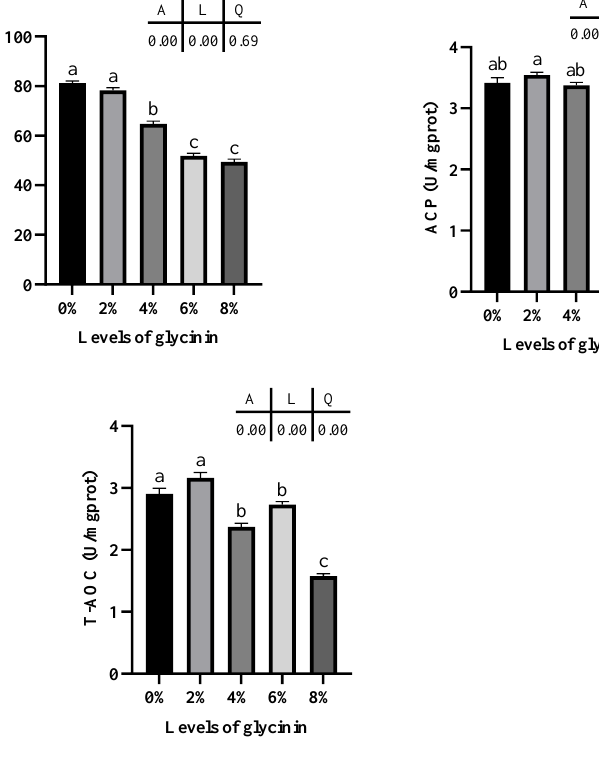
Figure 5. Protein metabolism enzyme activities in liver of hybrid yellow catfish fed with different glycinin levels. Data describe mean ± SE (n = 3). Obvious difference of means between groups is